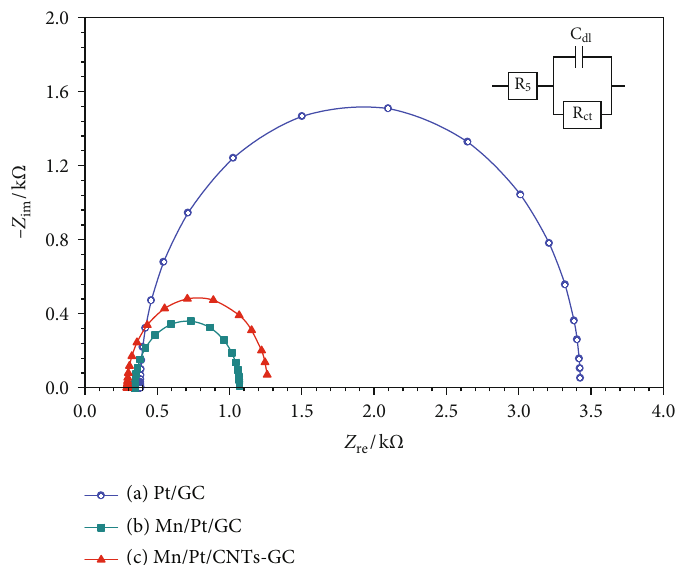
Figure 5: Nyquist plots obtained in 0.3M FA ( pH = 3 : 5 ) recorded at AC potential amplitude of 0.20V obtained at the (a) Pt/GC, (b) Mn/Pt/ GC, and (c) Mn/Pt/CNT-GC electrodes in 0.3M FA ( pH = 3 : 5 ). Frequency range from 10mHz to 100